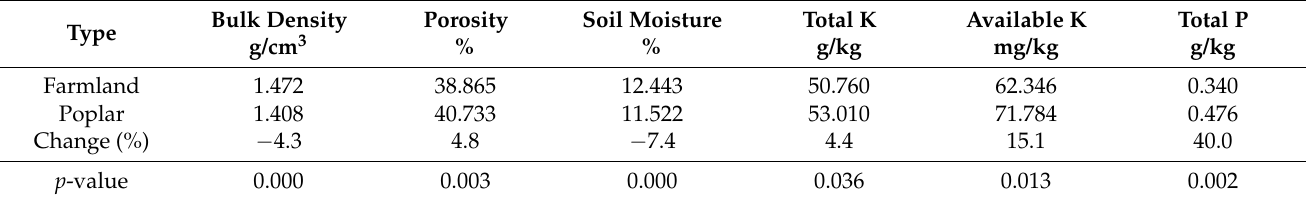
Table 2. Shelterbelts construction significantly affected 6 soil parameters ( p < 0.05), and magnitudes and pattern of the influences. The non-significant factors ( p > 0.05) were not listed